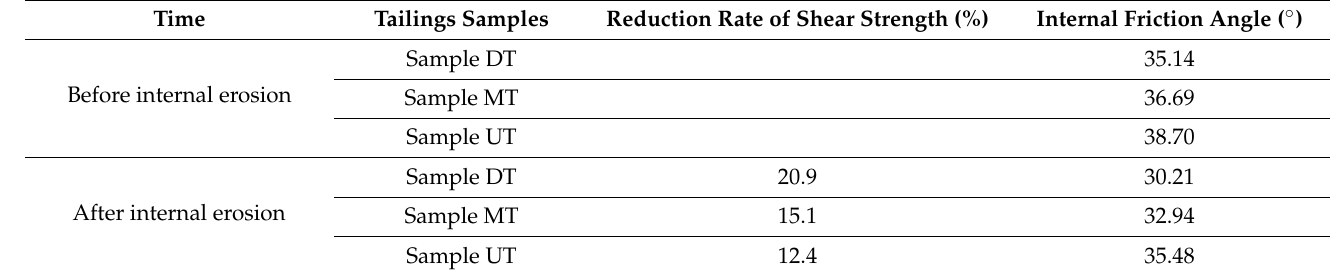
Table 5. The shear strength of tailings samples before and after internal